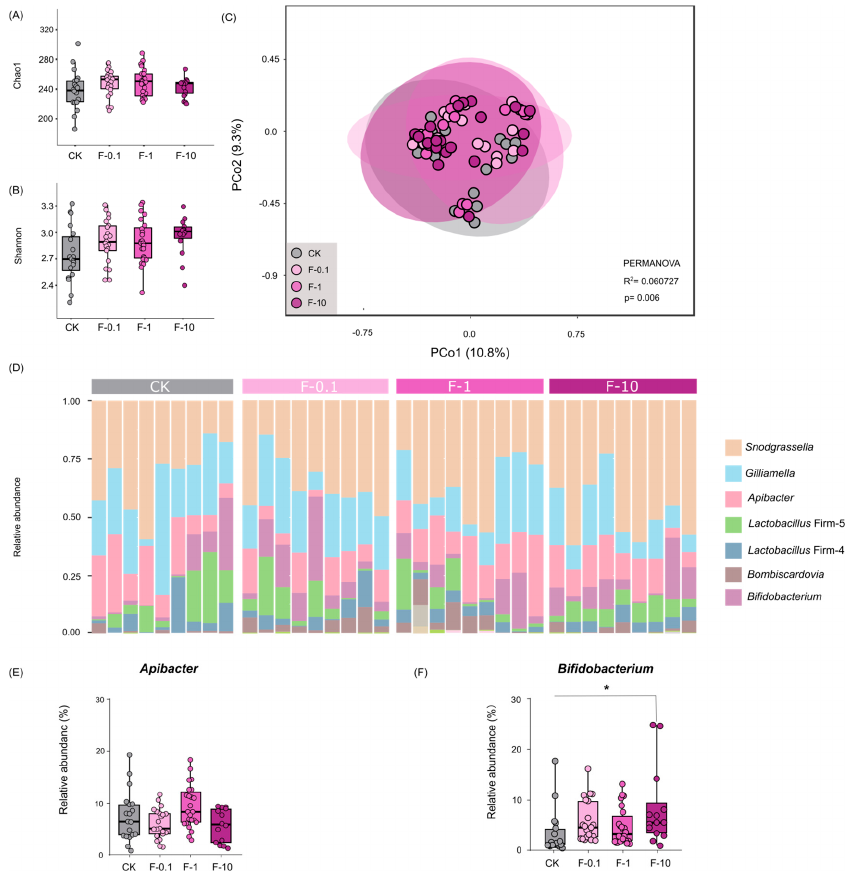
Figure 4. Gut microbiota compositions of the bumblebees under chronic exposure of flupyradifurone. ( A ) α -Diversity at genus level estimated by Chao1 richness index. ( B ) Shannon diversity estimator. ( C ) Principal coordinate analysis of gut community composition in control and flupyradifurone-treated bumblebees. ( D ) Bar graph of bacterial abundance at the genus level. ( E ) The relative abundance of Apibacter in the bee gut. ( F ) The relative abundance of Bifidobacterium in the bee gut. (* p < 0.05) (CK: n = 19, F-0.1: n = 21, F-1: n = 24, IM-10: n = 14) CK, F-0.1, F-1 and F-10 represent control, 0.1, 1, and 10 μ g/L flupyradifurone treatment.